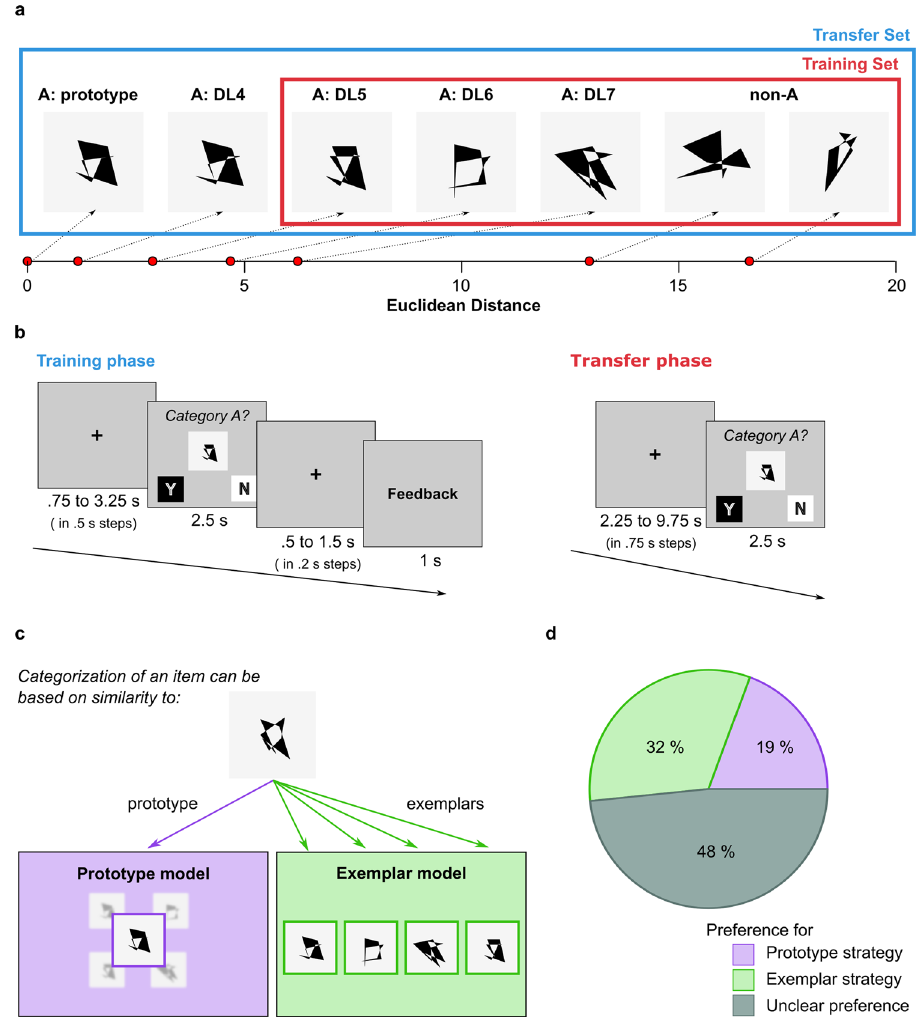
Fig. 1 Category learning task and behavioural results. a Examples for members of category A for each distortion level (DL) and non-members. The red frame illustrates that only medium to highly distorted category members and non-members were part of the training set. The blue frame illustrates that the transfer set consisted of a full range of stimuli. b Trial timing of the training and the transfer phase. Single training blocks had a duration of 2.8 min. Single transfer blocks had a duration of 4.8 min. Positions of ‘ yes ’ (Y) and ‘ no ’ (N) responses changed pseudo-randomly between left and right to preclude direct category to motor mapping 94 . c Conceptual illustration of the prototype and the exemplar model. The prototype model (purple) assumes that a category is represented as its central tendency, the prototype. The exemplar model (green) posits that a category is represented by storing individual category members as separate instances. Once category representations are established, the category membership of a new item can be determined by comparing its appearance to the representation of the prototype or to the stored exemplars. d Behavioural strategy preference. Percentages of volunteers ( n = 62) showing behavioural preferences for the prototype strategy (purple), the exemplar strategy (light green) and those who showed unclear preferences (dark